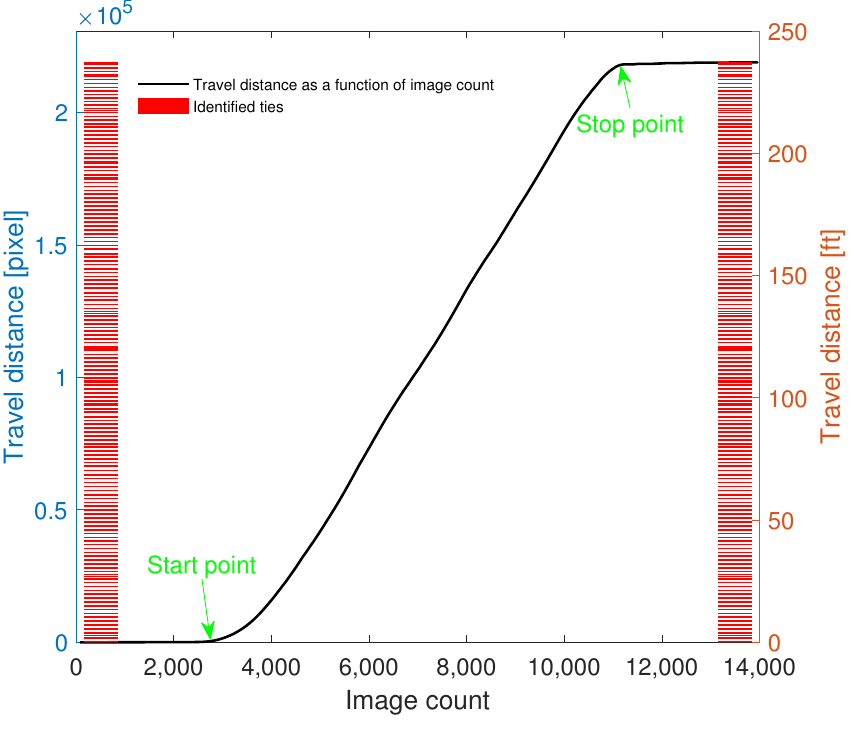
Figure 13. Image processing-based reconstructed travel distance and the obtained tie/ballast image classification results for a test